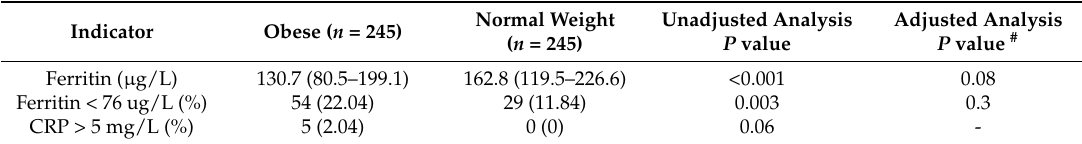
Table 3. Inflammatory and iron status indicators of neonates of obese and normal weight pregnant